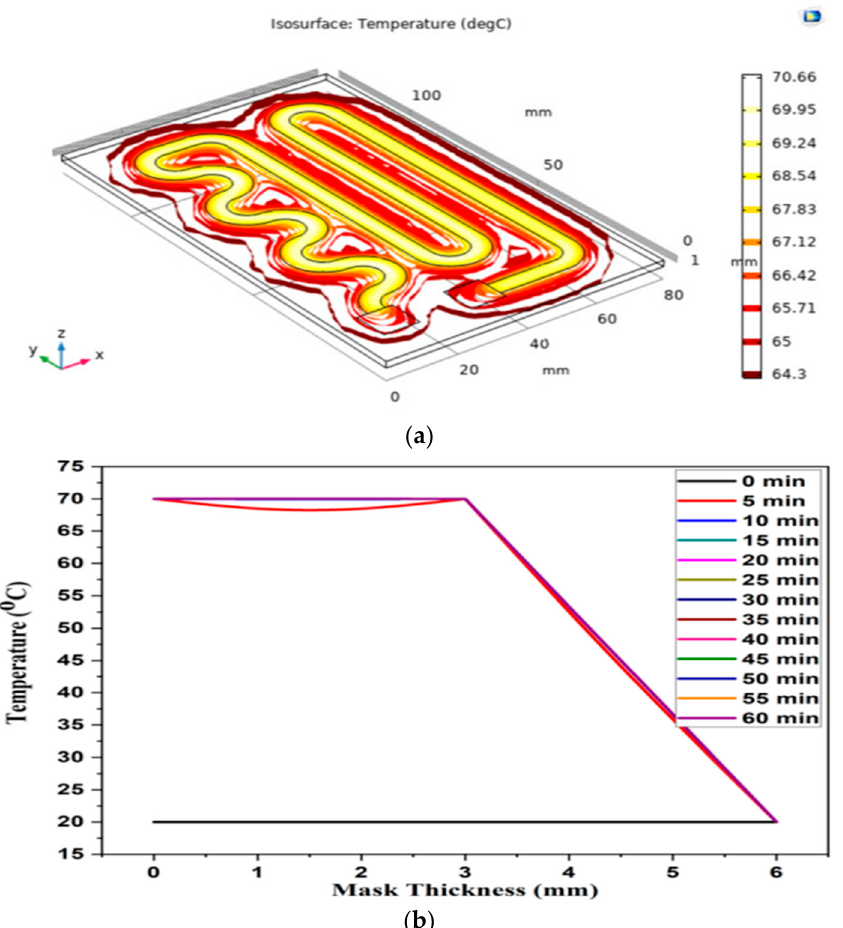
Figure 3. ( a ) Temperature profile of the mask at outer surface at L1; ( b ) total temperature with respect to the thickness of the mask.